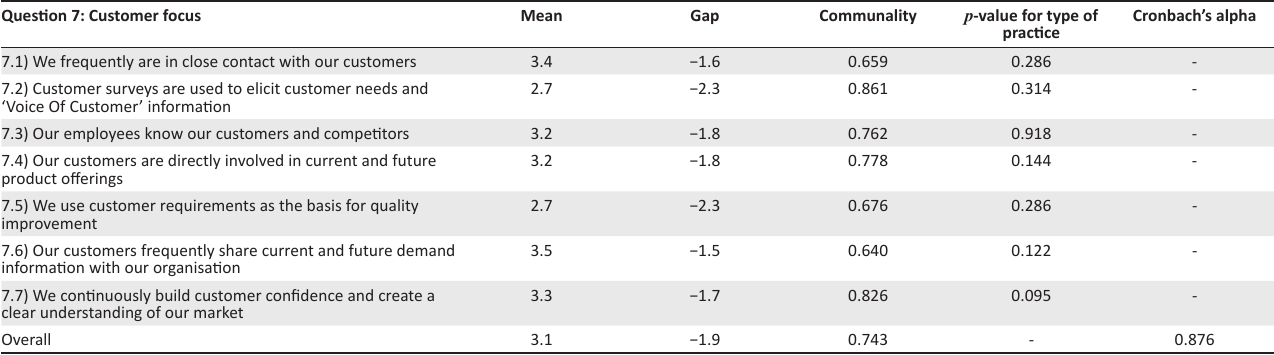
TABLE 8: Results pertaining to customer focus. Question 7: Customer